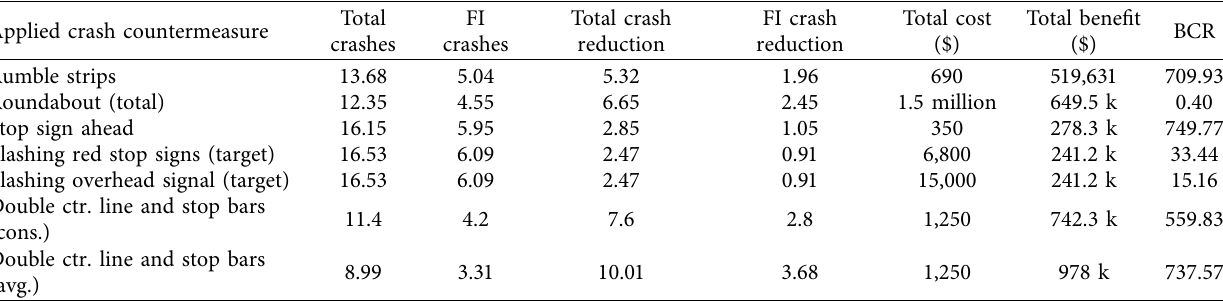
Table 3: Applied CMF analysis at an intersection.